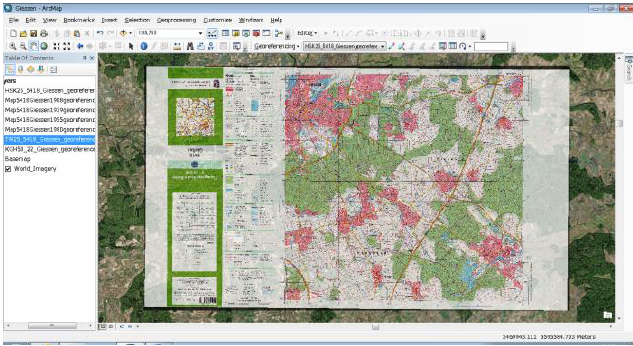
Figure 7. Topographic map, Giessen pronunciation in Germany